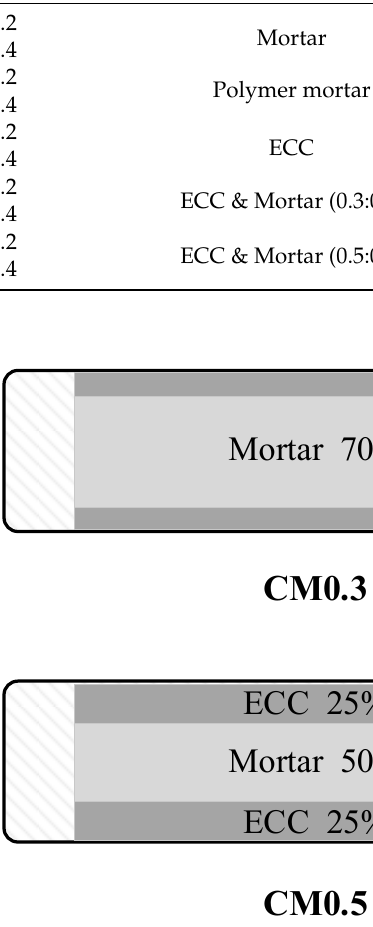
Figure 3. Details of composite mortar.